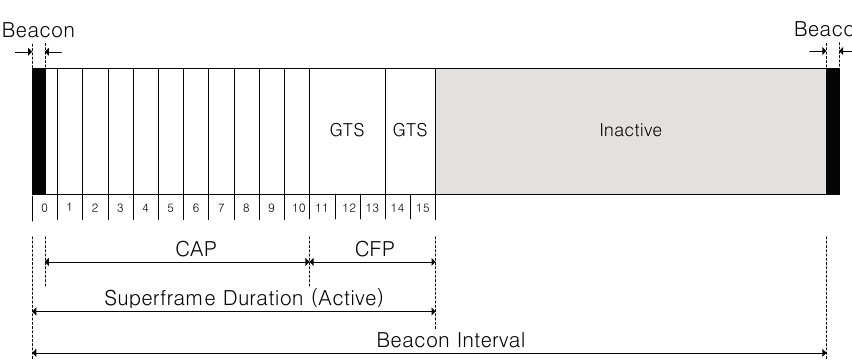
Figure 2. IEEE 802.15.4 superframe